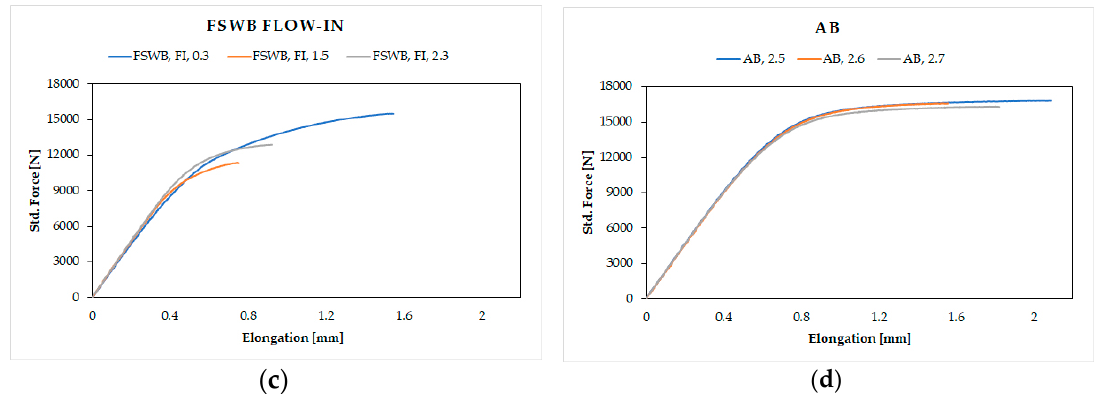
Figure 5. Lap-shear test results for: ( a ) FSW joints; ( b ) FSWB-WT joints; ( c ) FSWB-FI joints; ( d ) adhesive bonding (AB) joints.